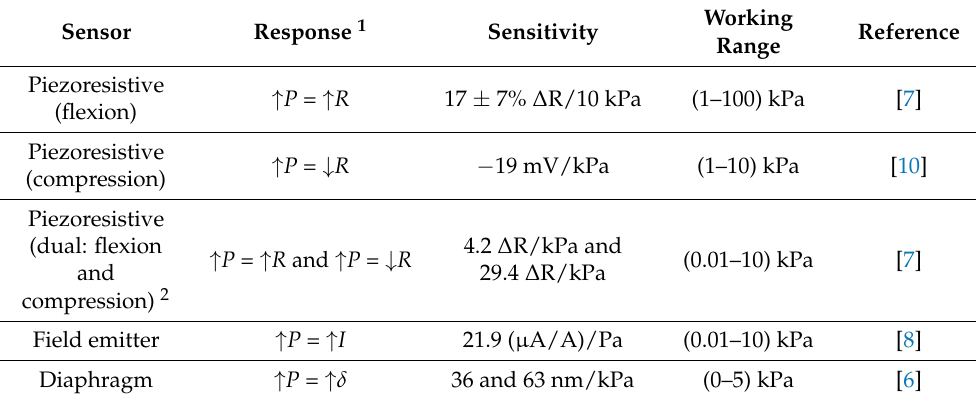
Table 1. Characteristics of graphene-based pressure sensors.